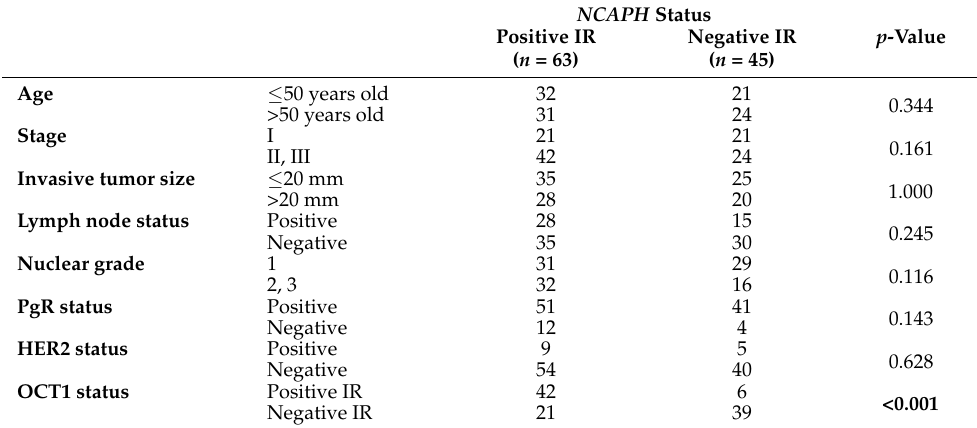
Table 3. Relationship between NCAPH immunoreactivity and clinicopathological parameters in ER-positive breast cancer